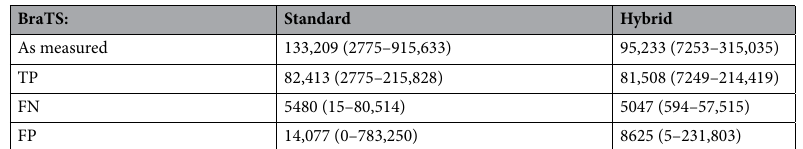
BraTS: Standard Hybrid As measured